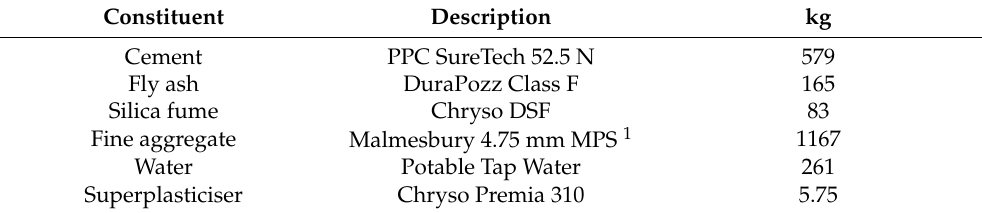
Table 1. Three-dimensional printing cementitious material used for this study.